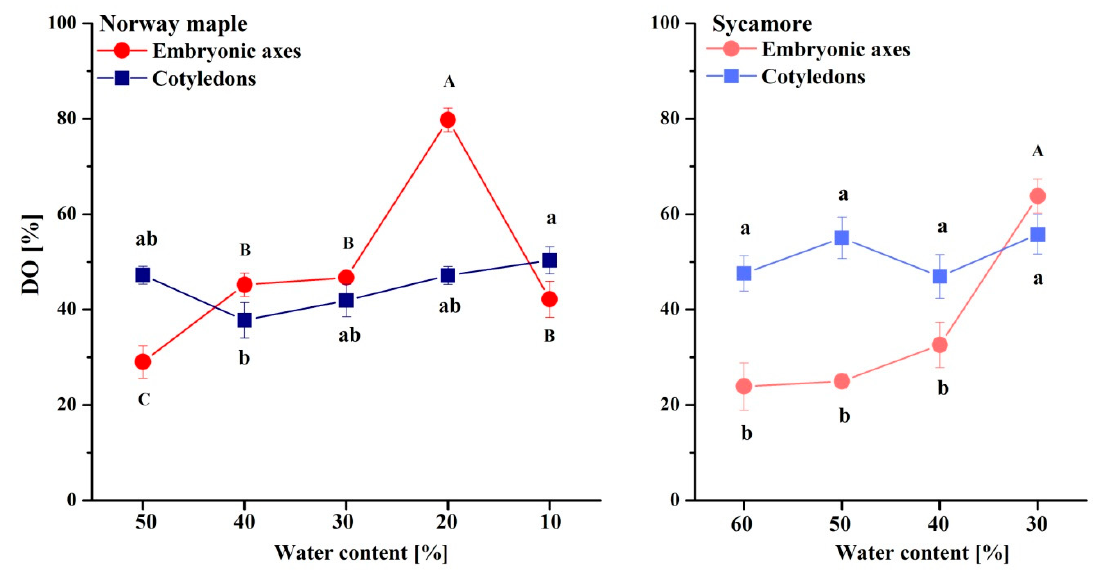
Figure 6. Degree of oxidation (DO) of glutathione in the embryonic axes and cotyledons of desiccated Norway maple and dehydrated sycamore seeds. The data are the means of three independent replicates ± the STDs. The same letters indicate groups that are not significantly different according to Tukey’s test. The capital letters refer to cotyledons.